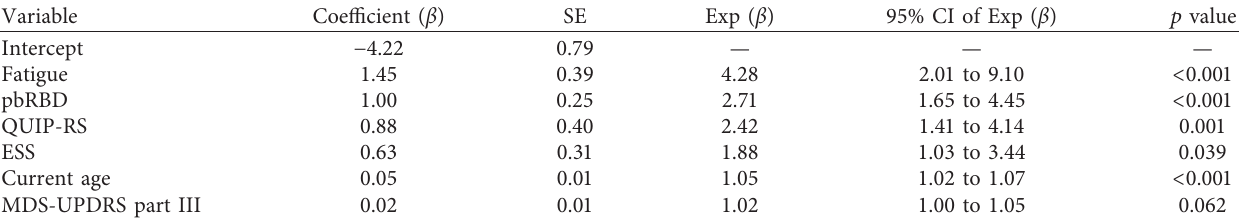
Table 4: Regression model predicting a SCOPA-AUT score of ≥ 10 in patients with early PD (not including MDS-UPDRS parts I, II, and